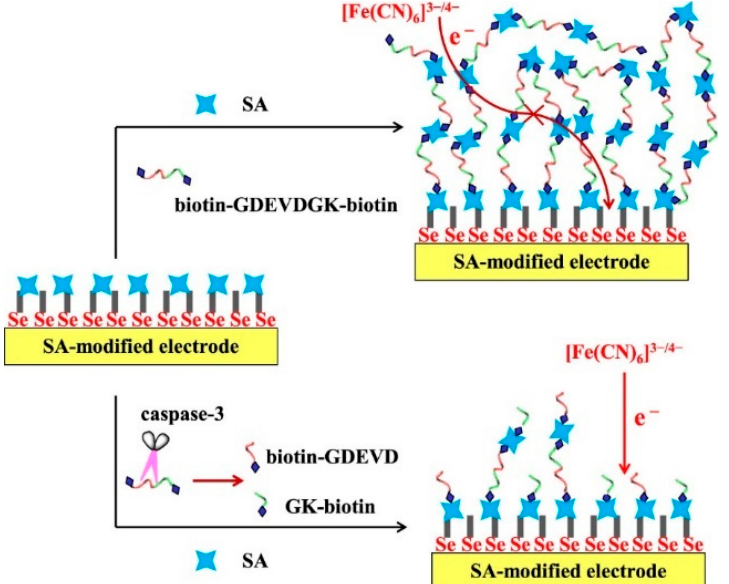
Figure 12. Schematic representation of the surface-tethered electrochemical analysis for caspase-3 detection [96]. Copyright 2021 American Chemical Society.